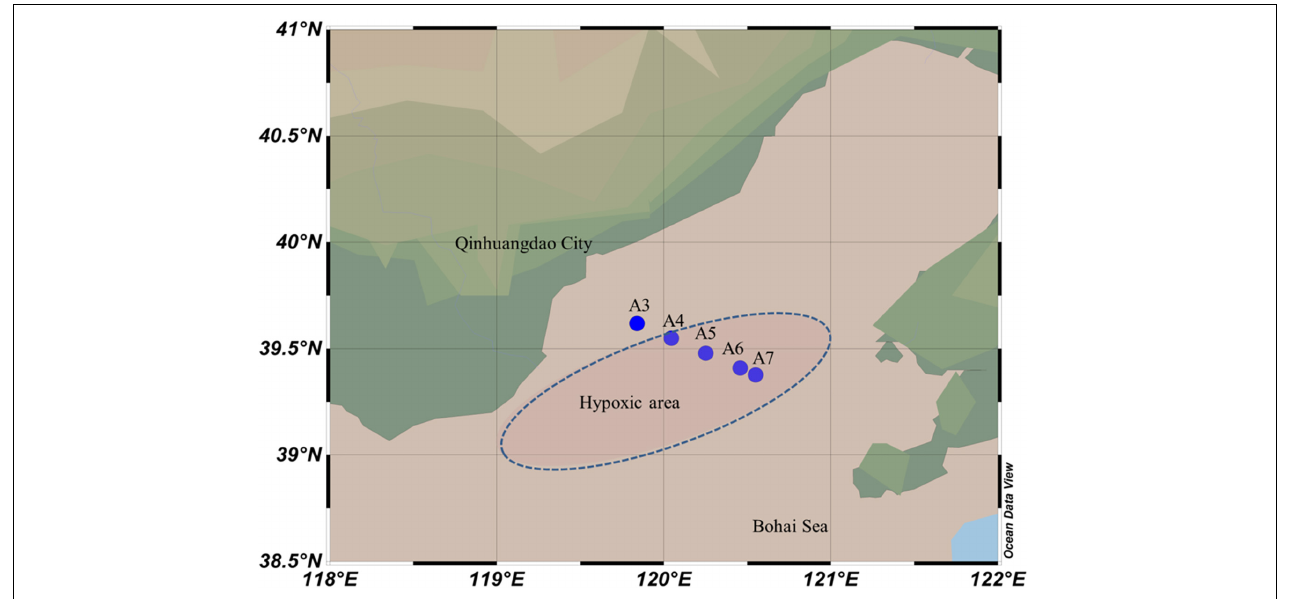
FIGURE 1 | Map showing the sampling sites in Bohai Sea along inshore—offshore transect. The blue dash line oval showing the reported hypoxic